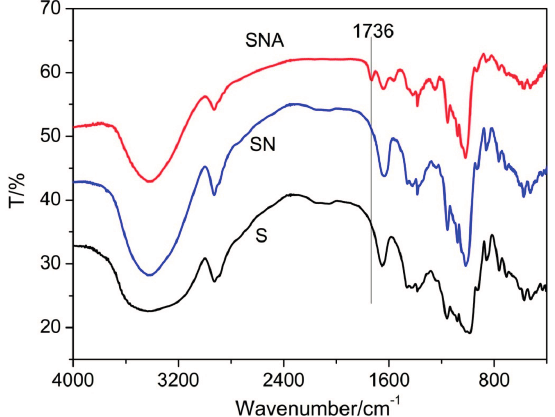
Figure 1. FTIR spectra of S, SN and SNA.